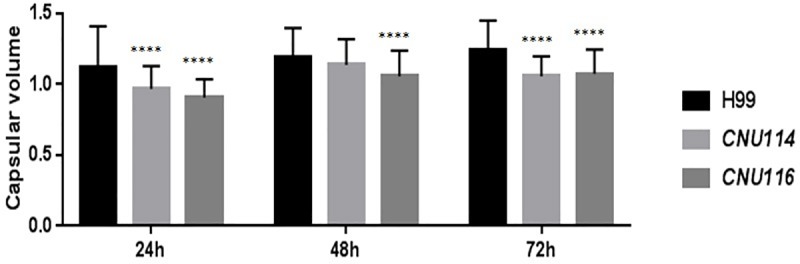
Capsule volume in wild type H99 and two independent transformants (CNU114 and CNU116) of a double mutant aap1Δ/aap2Δ at 37°C during 24, 48 and 72 hours.p < 0,001.